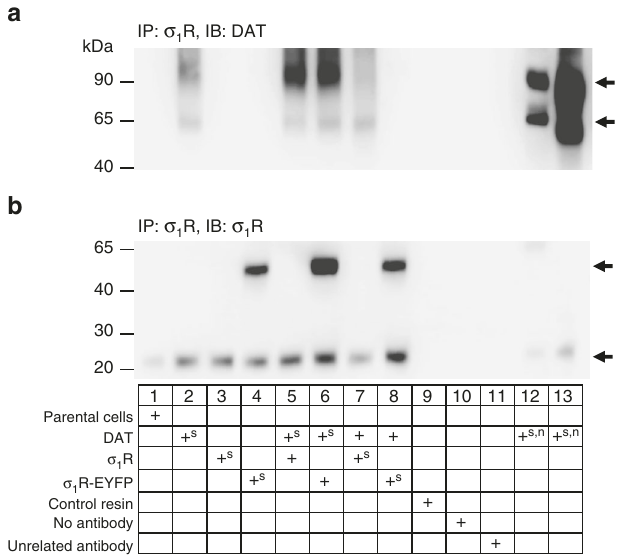
Fig. 8 Co-immunoprecipitation reveals interaction between σ 1 R and DAT. a Western blots of immunoprecipitated (IP) HEK-293 extracts with an anti- σ fi es bands 1 R antibody and probing with an anti-DAT antibody identi corresponding to mature (top arrow) and immature forms (bottom arrow) of DAT only when σ 1 R and DAT are co-expressed. b Re-probing of the membrane with anti- σ 1 R shows expression of σ 1 R (lower arrow) and σ 1 R- EYFP (top band). The control resin, absence of speci fi c antibody, and presence of a non-speci fi c antibody (lanes 9 – 11) serve as negative controls. The σ 1 R band represents ectopic and endogenous σ 1 R expression. + s indicates stable expression of the respective protein. + n indicates samples from crude lysates (non-IP). Twenty micrograms of total protein was used in the lane 12 non-IP sample, whereas 40 μ g was used in the lane 13 non-IP sample. The representative blots depict the fi ndings from ≥ 3 independent